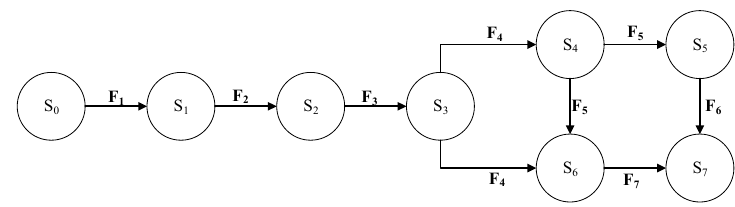
Figure 8. Schematic diagrams of state transition.